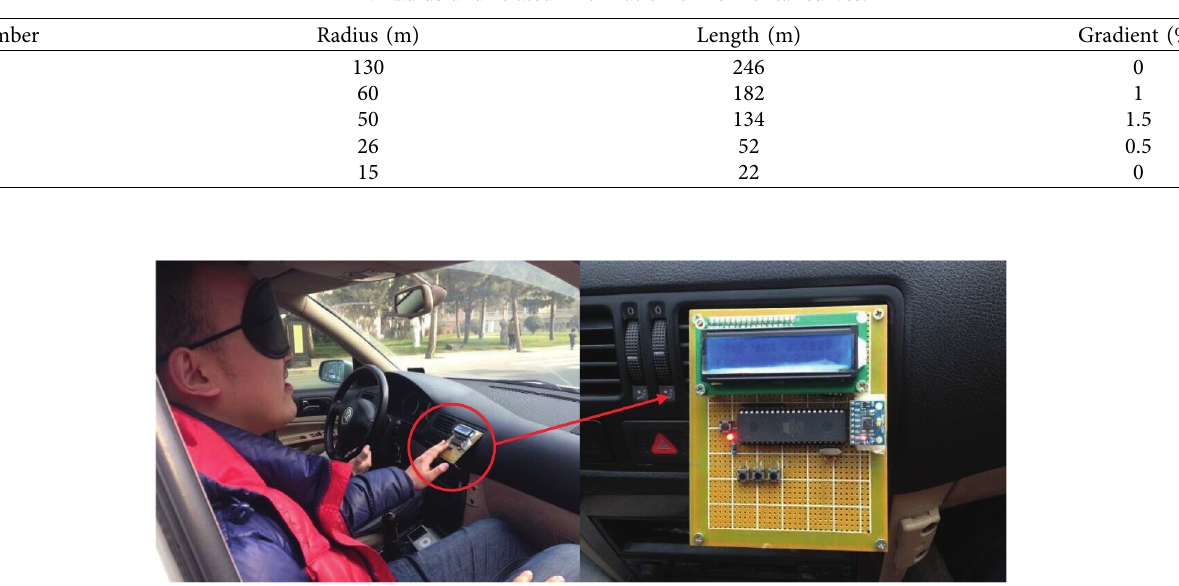
Figure 4: Instrument used in this study and record of field experiment.